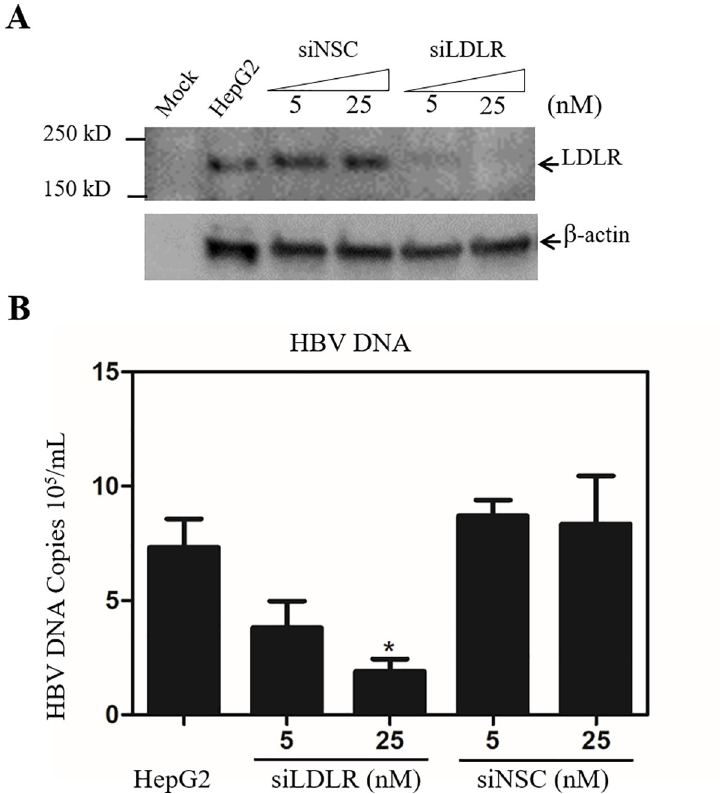
Fig 9. Reduction of HBV cell attachment by siRNA-induced silencing of LDLR expression in HepG2 cells. The LDLR-specific siRNAs (siLDLR) and a non-specific control siRNA (siNSC) were transfected into parental HepG2 cells in 24-well plates in the same way as in Fig 4. After 48 hrs post-transfection, cells were incubated with HBV at 37˚C for 12 h. The unbound HBV was removed by aspiration and washing with PBS three times. The cell-bound HBV DNA was extracted and quantified as described in Fig 8. Cells were also lysed in a RIPA buffer for determining the levels of LDLR by a Western blot analysis. A . Determination of LDLR expression. The levels of LDLR in siRNA-transfected HepG2 and mock control HepG2 were determined by Western blot using an LDLR-specific monoclonal antibody (HL-1). β -actin was used as an internal control. B . The levels of HBV DNA determined by a qPCR method. The genomic HBV DNA copies were calculated as average of three repeats. The concentrations of siRNA are indicated on the top (A) or bottom (B). Protein size markers are shown on the left.